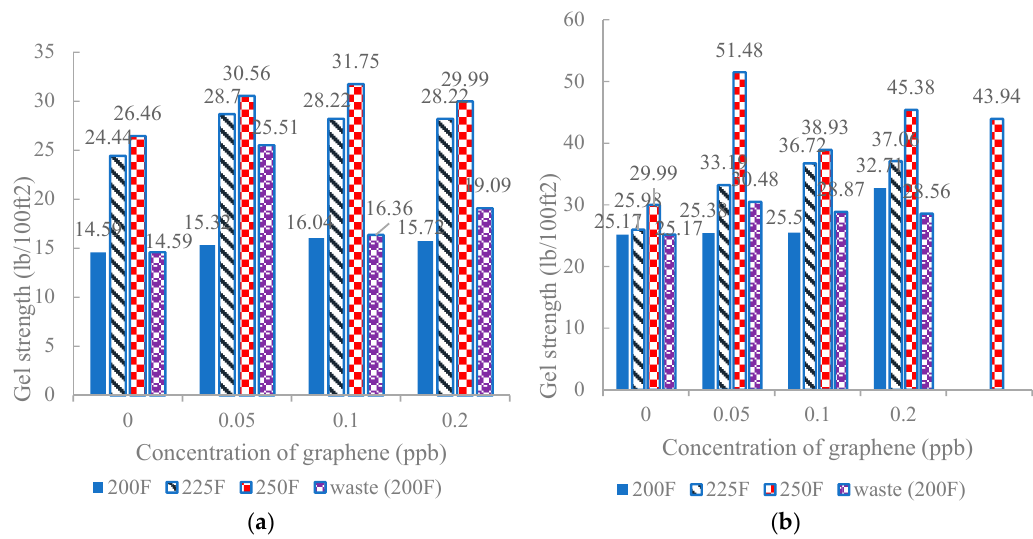
Figure 3. Gel strengths of different concentrations of graphene after aging: ( a ) 10 s and ( b ) 10 min. Reproduced with permission from [61]. Copyright IOP Publishing, 2020.